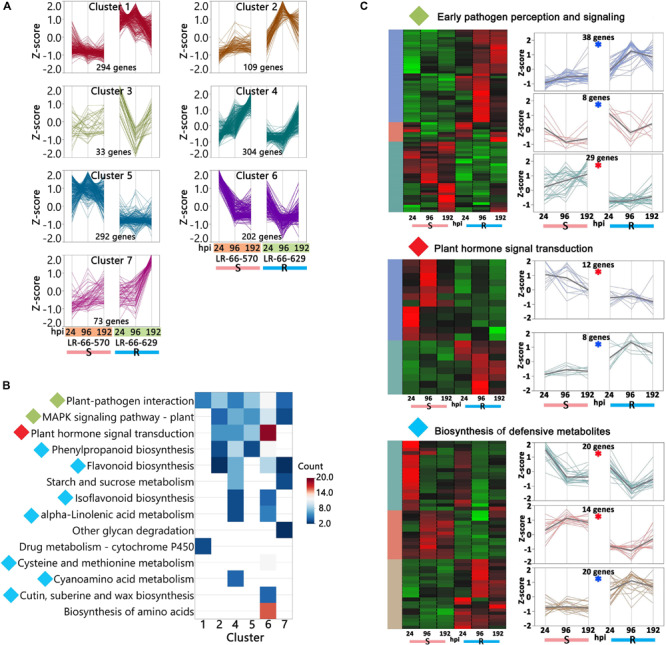
Analysis of differentially expressed genes (DEGs) between the susceptible Lens ervoides RIL LR-66-570 and the resistant RIL LR-66-629 after inoculation with Ascochyta lentis. (A) Hierarchical clustering (Ward’s method) analysis revealing seven clusters containing 1,307 DEGs. (B) Significant KEGG terms (adjusted P < 0.05) enriched for six clusters. No significant KEGG term was retrieved for cluster 3. KEGG terms with diamonds to the left of name were recognized as possible pathways that influenced A. lentis defense, where green indicated “Early pathogen perception and signaling,” red “Plant hormone signal transduction” and cyan “Biosynthesis of defensive metabolites.” (C) Identification of putative DEGs that may confer A. lentis susceptibility or resistance. Hierarchically clustering (Ward’s method) was performed for those genes involved in “Early pathogen perception and signaling,” “Plant hormone signal transduction” and “Biosynthesis of defensive metabolites.” Clusters with blue asterisk consisted of genes that were upregulated in the resistant RIL LR-66-629, those with red asterisk were upregulated in the susceptible RIL LR-66-570.